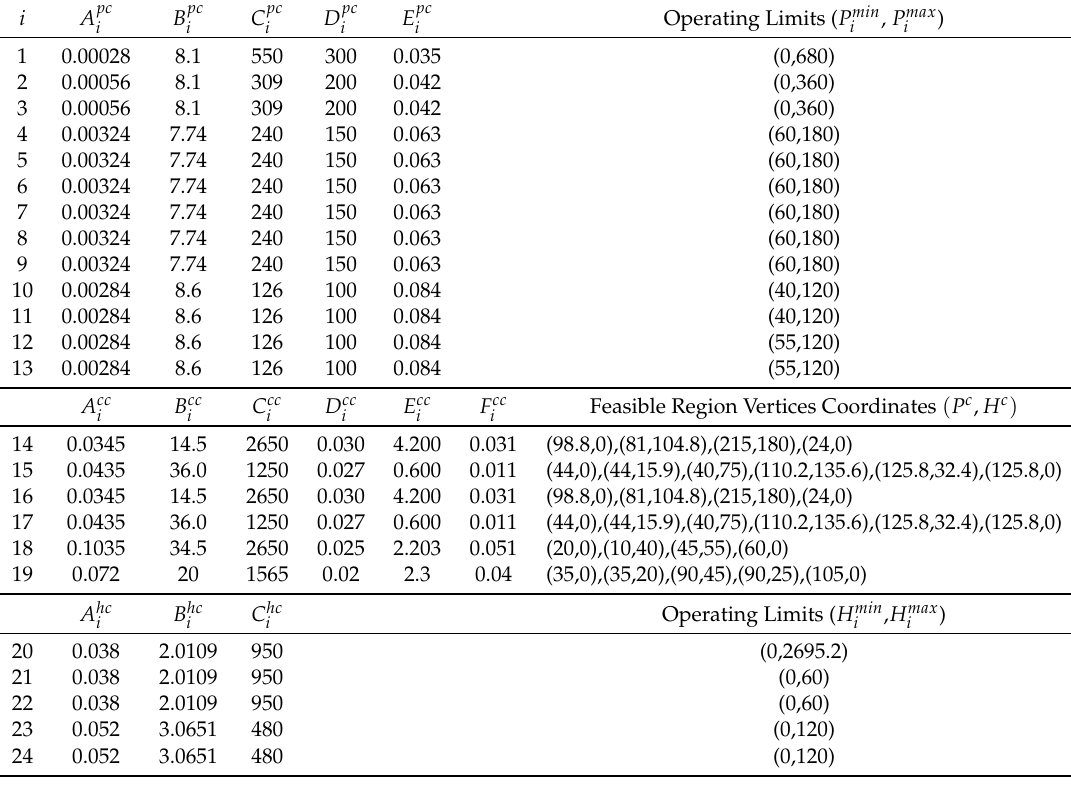
Table A8. Cost functions and operating limits of generating units for test instance 4.